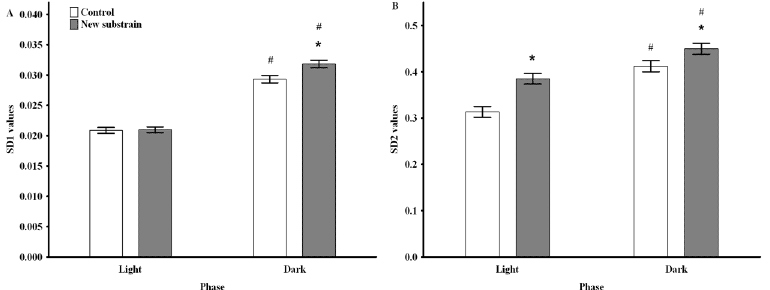
Fig 5. Poincaré plot analysis of body temperature in undisturbed circumstances during light and dark phases. Changes in SD1 (A) and SD2 (B). * p < 0.05 between groups; # p < 0.05 between the day cycles. Data are presented as means ±